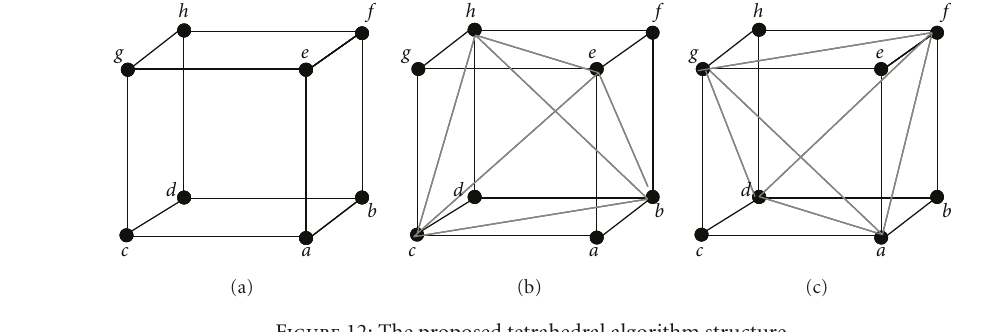
Figure 12: The proposed tetrahedral algorithm structure.